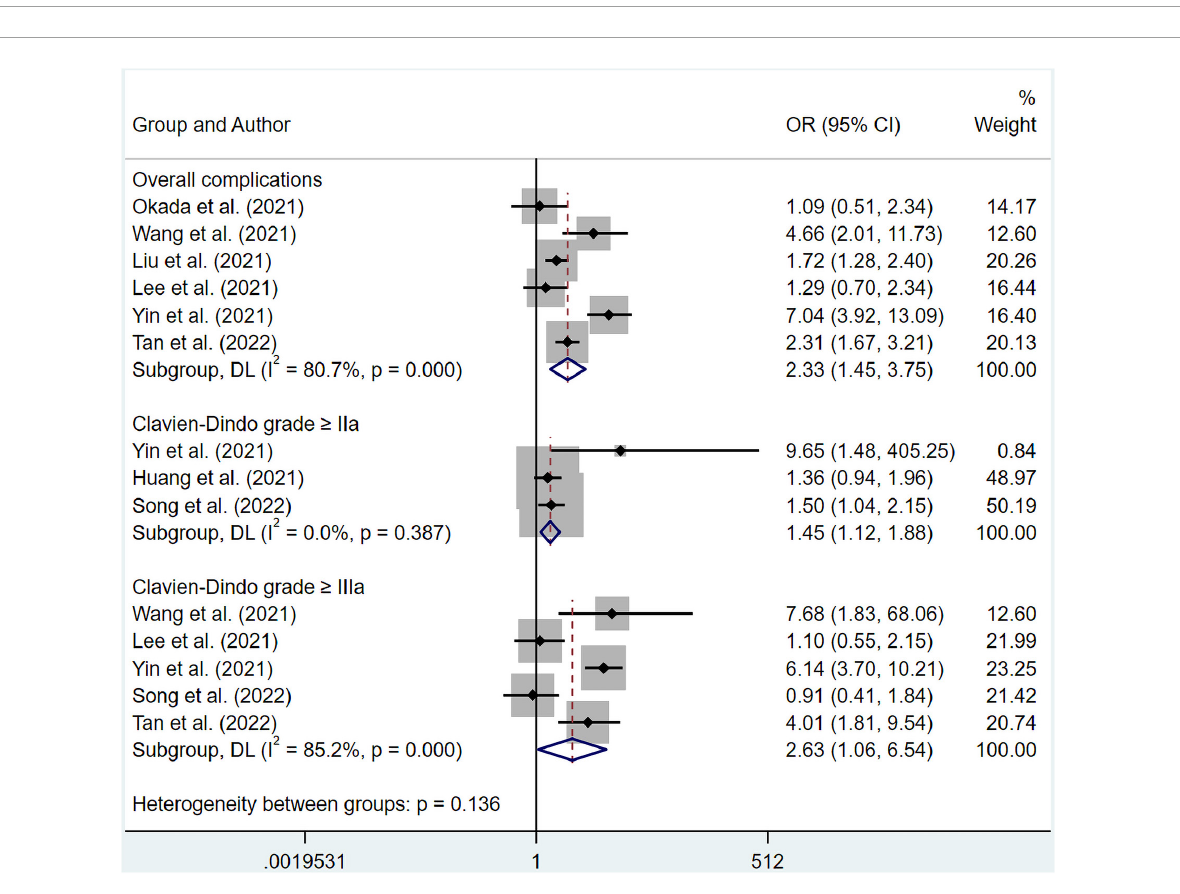
FIGURE6 Forest plots showing pooled HR with 95% CI of postoperative complications under univariate regression model. X-axis indicated odds ratio (OR). Weights and between-subgroup heterogeneity test are from random-effects